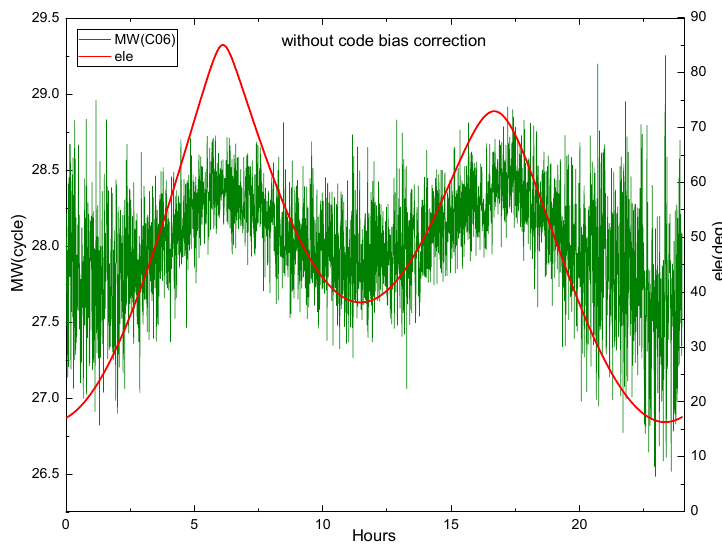
Figure 4. The M-W variation of C06 at XMIS, on DOY 083, 2018.